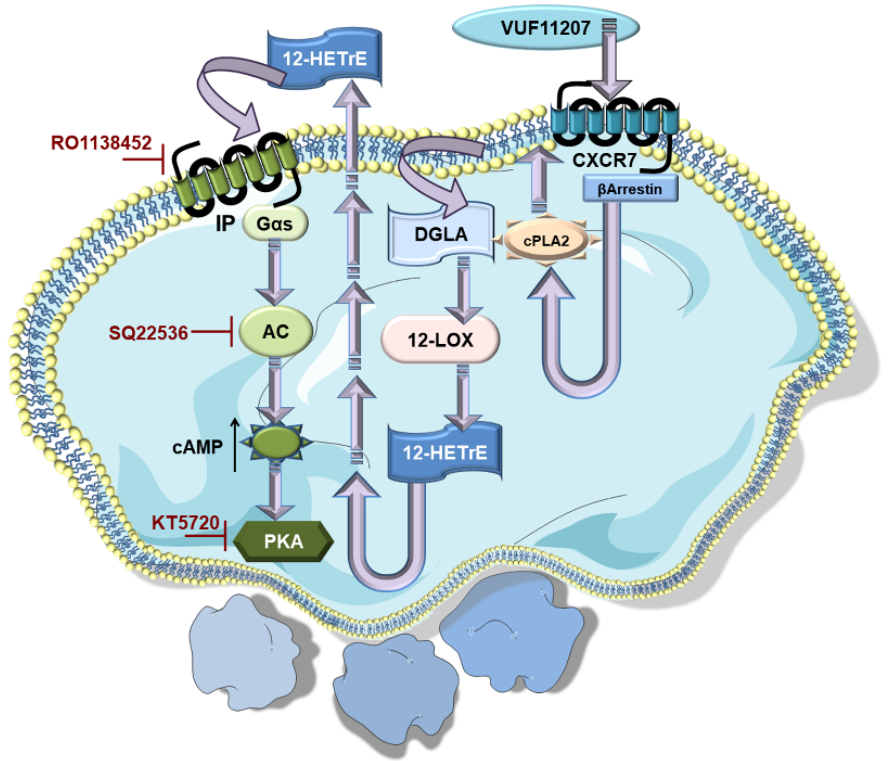
Figure 3. Non-canonical ACKR3/CXCR7 co-ordinates with canonical G α s-coupled IP-receptor to impose platelet inhibition. ACKR3/CXCR7-ligation by a pharmacological agonist (VUF11207) modu- lates the platelet lipidome, leading to an increased generation of anti-platelet lipid DGLA.12-LOX metabolizes DGLA into 12-HETrE, its anti-platelet oxylipin derivative. 12-HETrE released in the mi- croenvironment engages the G α s-coupled IP receptor on platelets. This triggers the platelet inhibitory AC-cAMP-PKA signaling cascade, as adenylyl cyclase (AC) is activated to elevate cAMP levels and triggers the downstream cyclic nucleotide dependent protein kinase A (PKA). Therefore, platelet inhibitory effects of CXCR7-agonist are reduced in the presence of pharmacological interventions in the form of IP-receptor antagonist (RO1138452), AC (SQ22536), and PKA (KT5720)